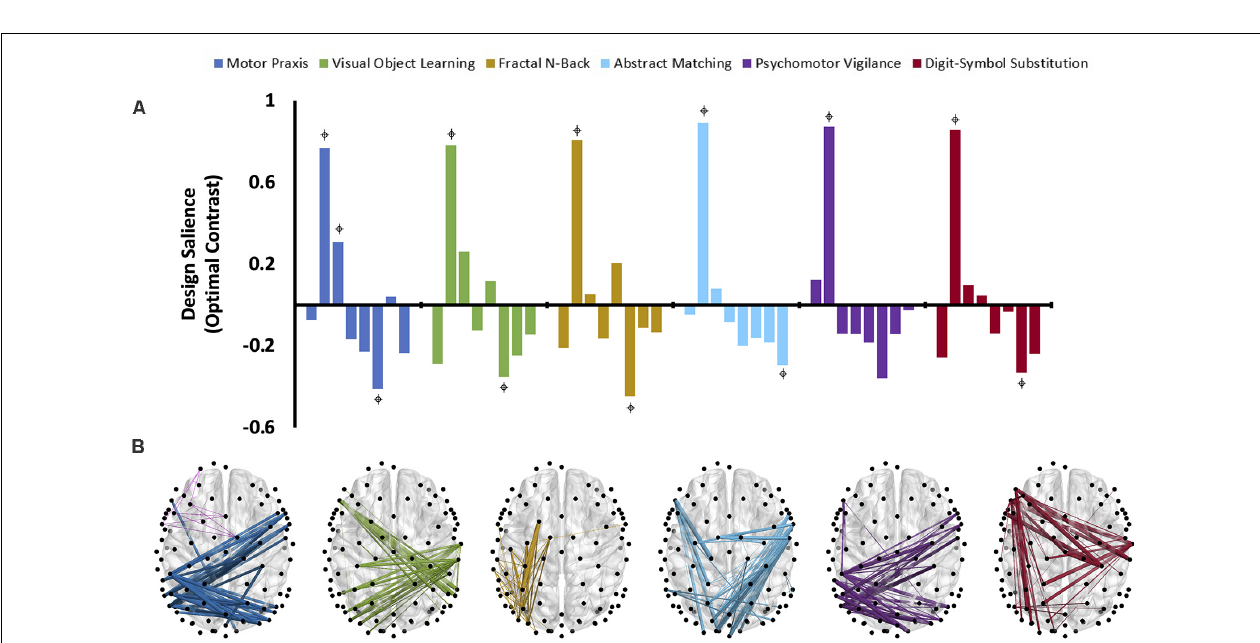
FIGURE 5 | The dominant latent variables (LV = 1 in all cases) capturing the distinct networks of maximal functional connectivity covariance across all eight cognitive testing sessions corresponding to each cognitive task in the alpha bandwidth (PLS analysis, variation 3). (A) Design saliences associated with network changes for each cognitive test across all eight sessions, where each bar corresponds to a single cognitive testing session. ⌖ = non-zero bootstrap-estimated 95% confidence interval. Permutation-estimated p -values and proportions of attributable cross block covariance (ES) associated with the significant latent variable are included in Table 2 . (B) The top 1% of connections corresponding to each cognitive test that reliably express the contrast, determined by thresholding the bootstrap ratios.